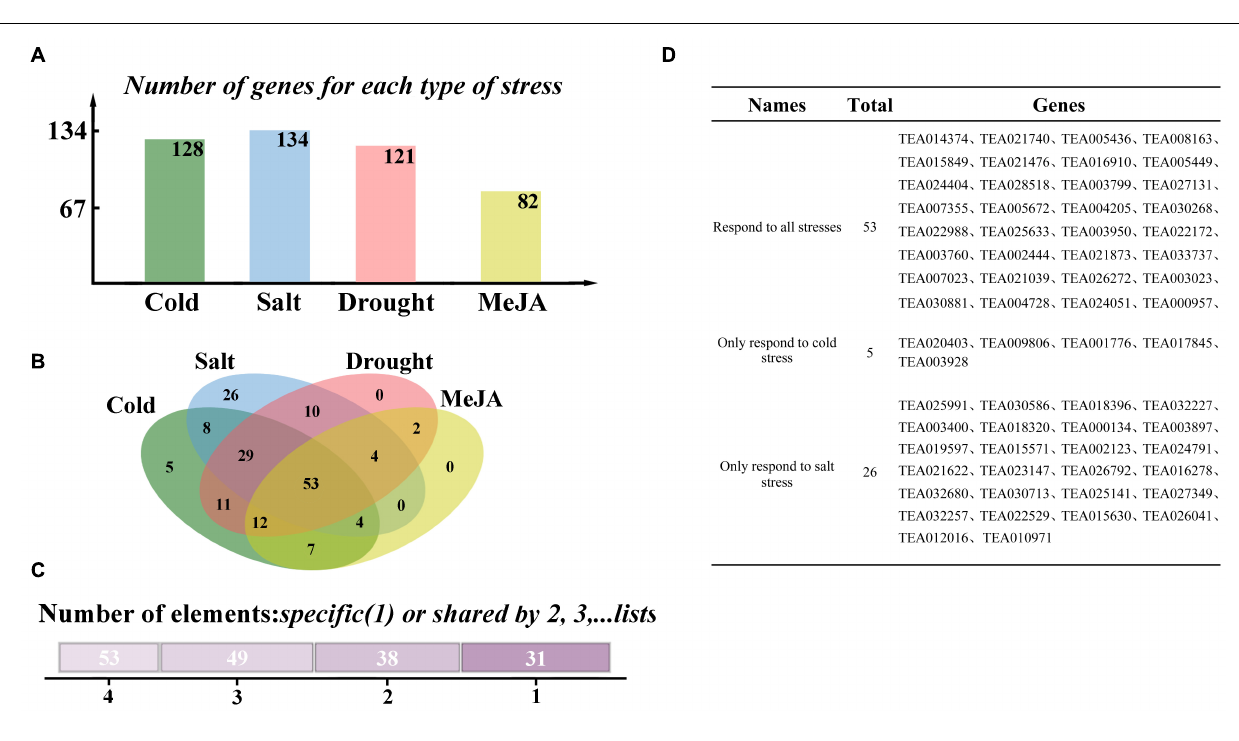
FIGURE 2 | Selection of RING-containing proteins in response to stresses in tea plants. (A) Number of genes responding to various types of stresses. (B) Venn diagram of genes responding to different stresses. (C) The number of genes responding to stresses at the same time. (D) List of genes responding to different